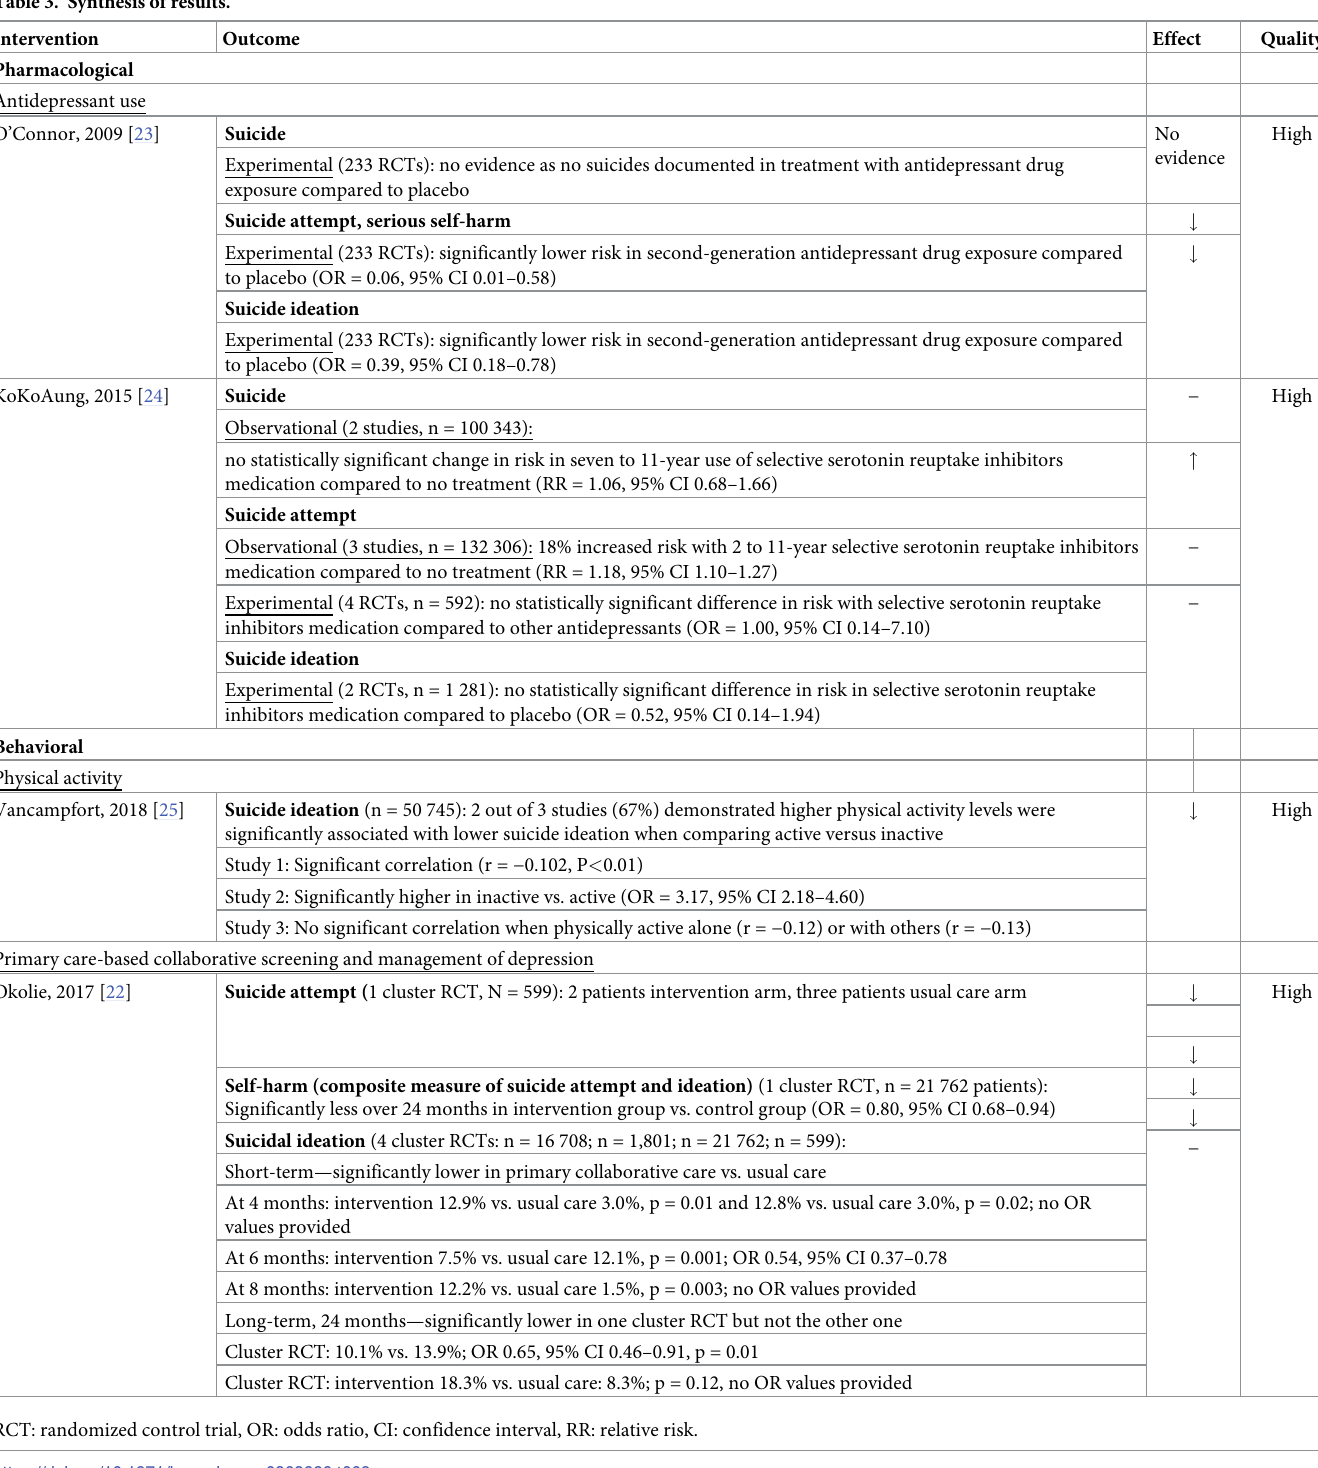
Table 3. Synthesis of